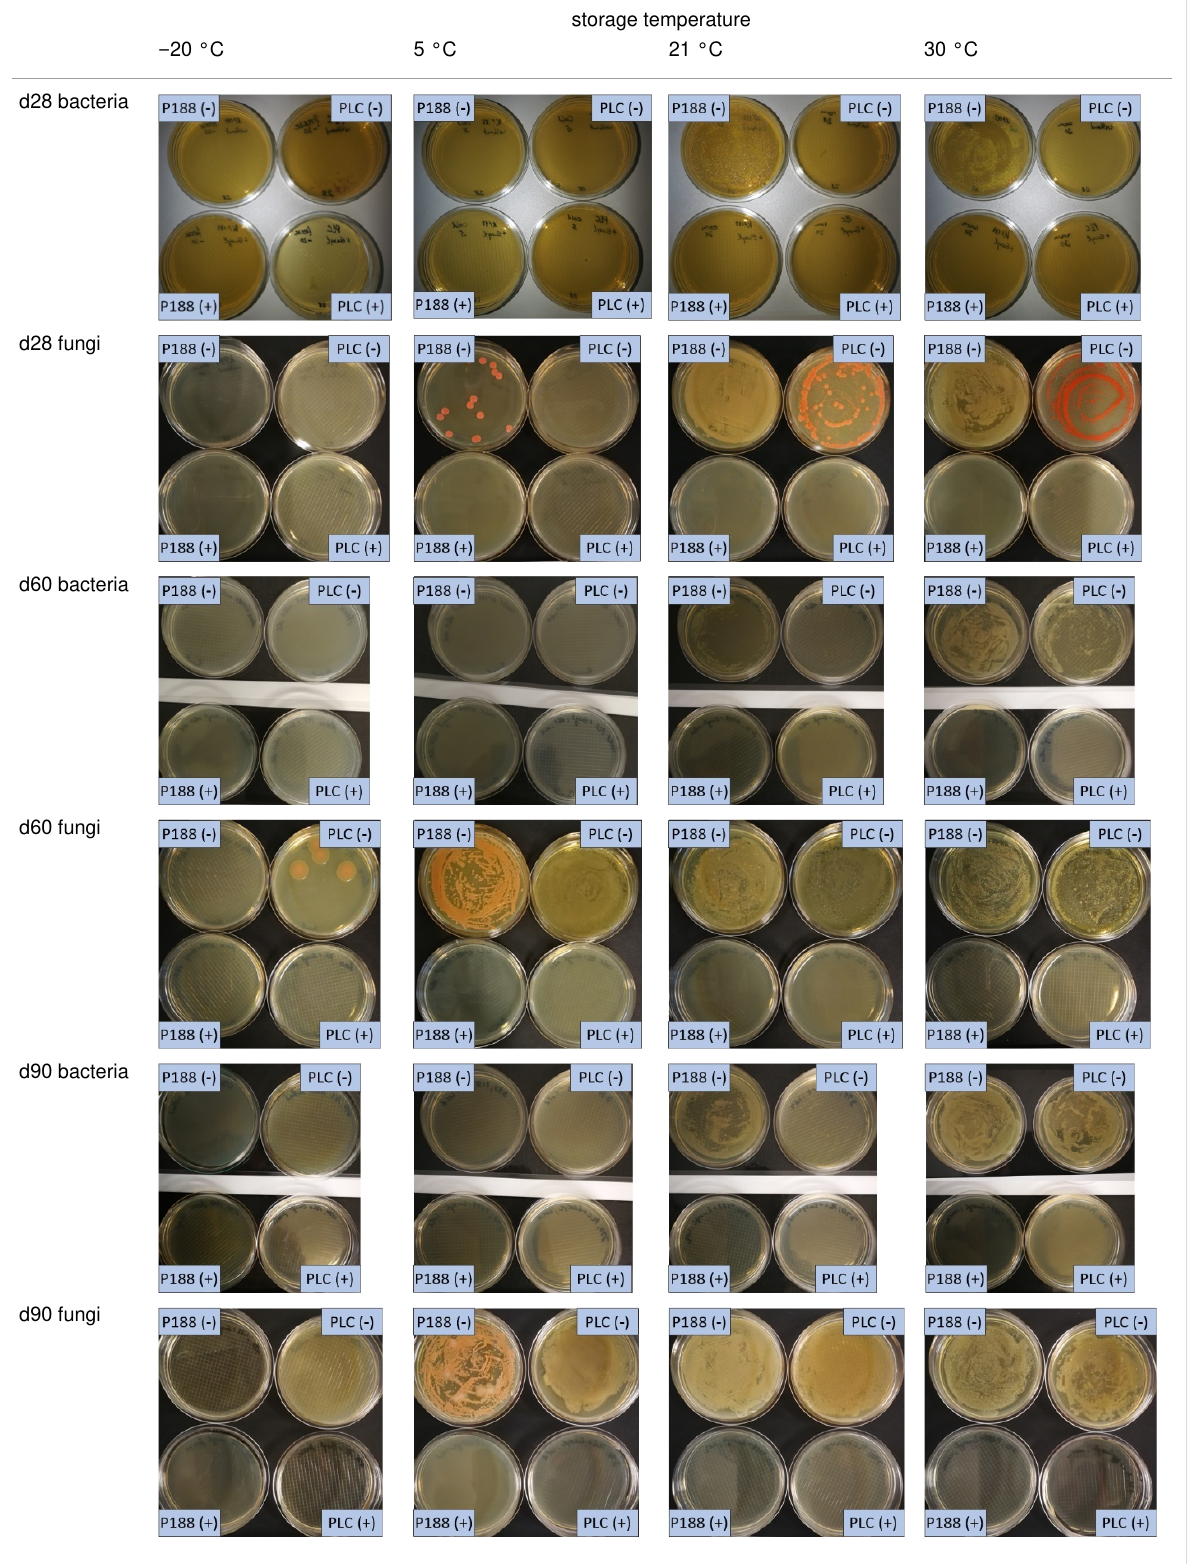
Table 3: Determination of microbial quality during three months of storage. P188: rutin nanosuspension stabilized with Poloxamer 188, PLC: rutin nanosuspension stabilized with Plantacare 2000, (+) = preserved with Euxyl 9010, ( − )